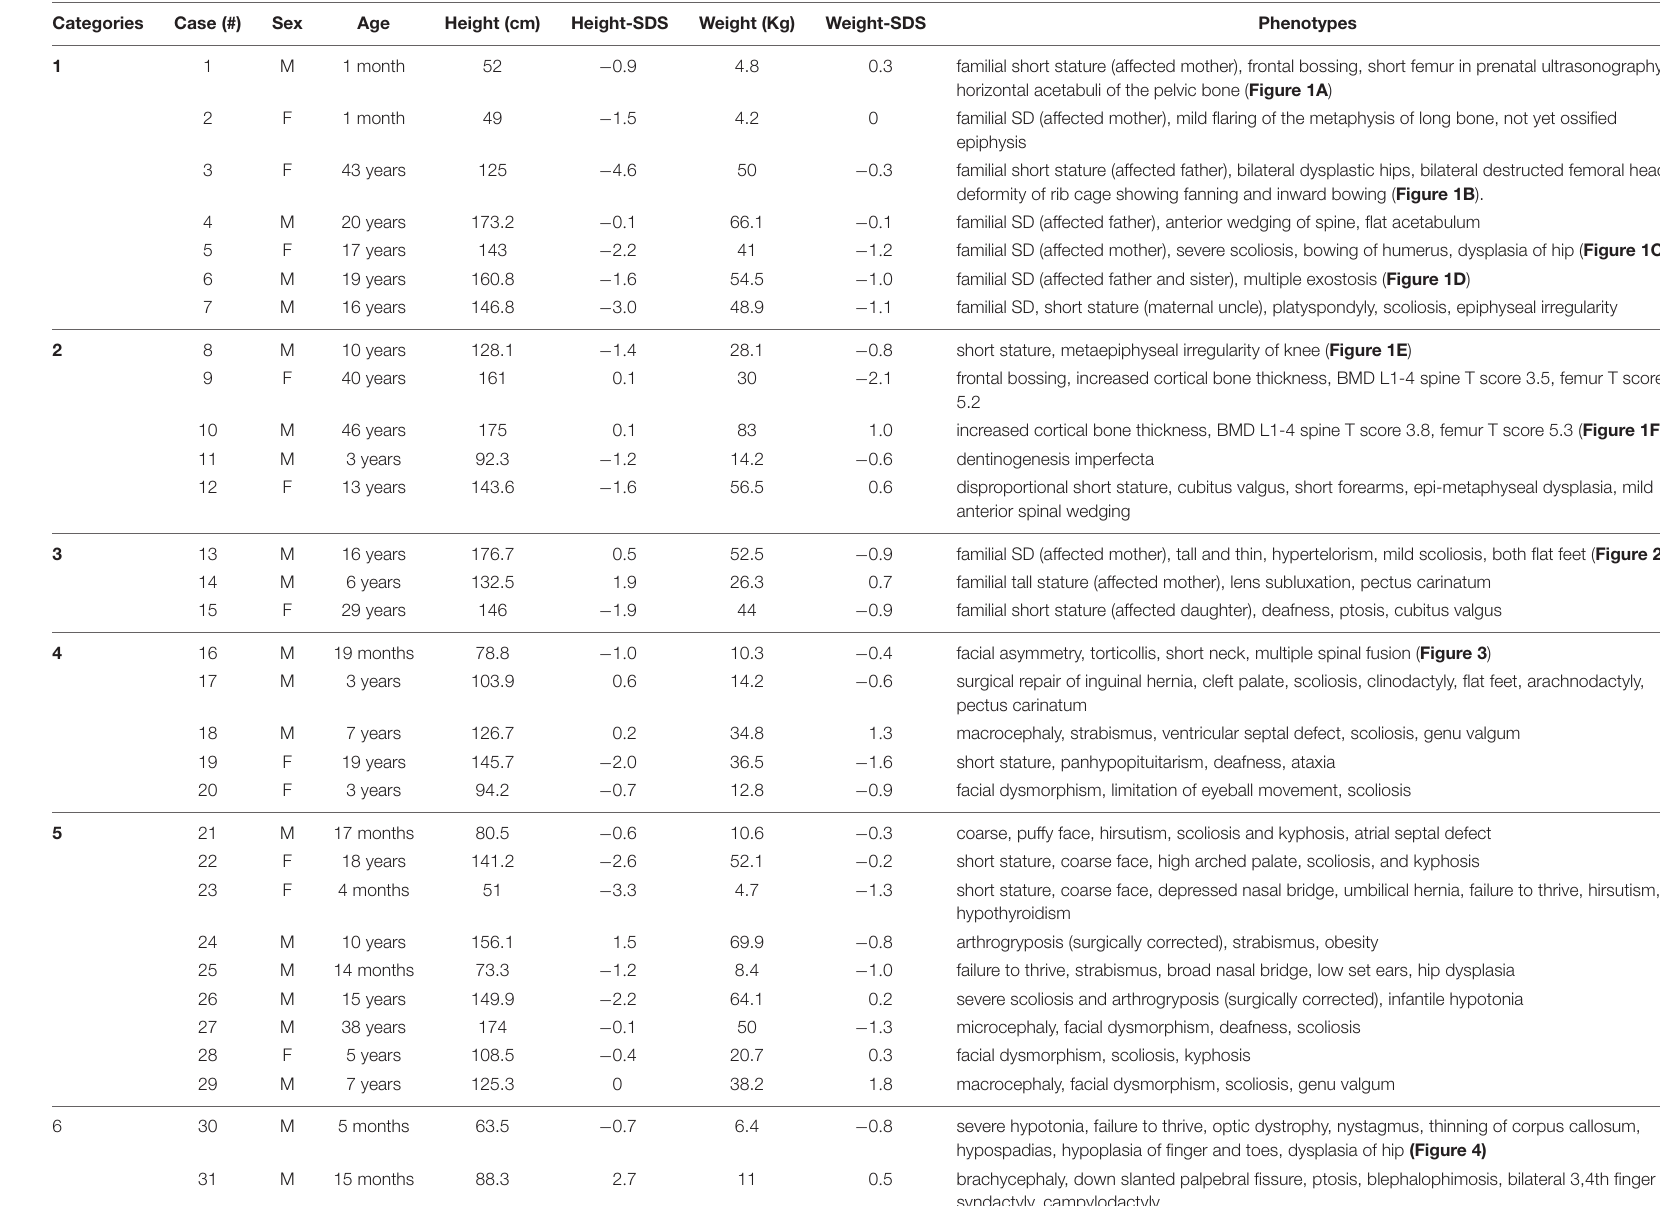
TABLE 2 | Demographics and clinical manifestations of the